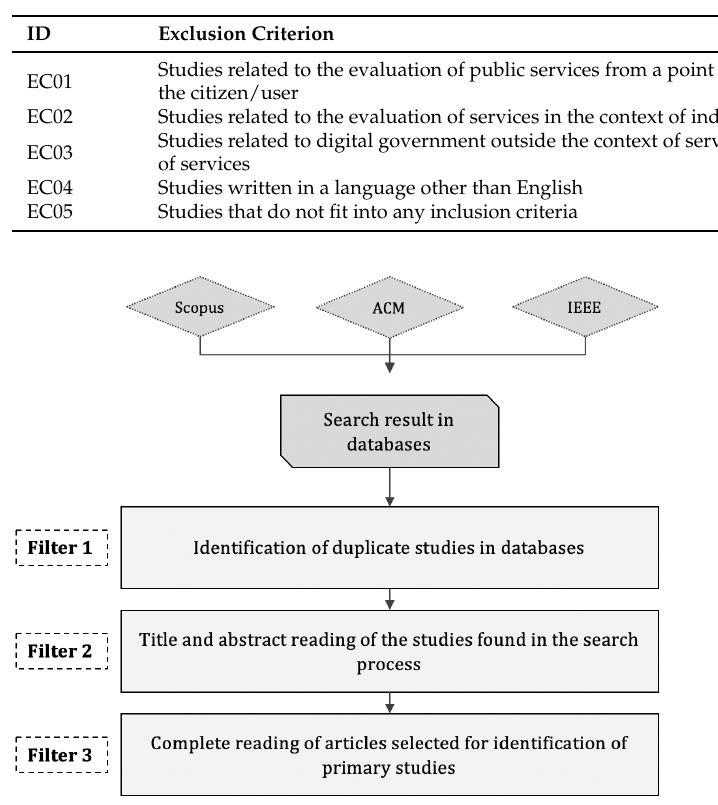
Table 4. Exclusion criteria.